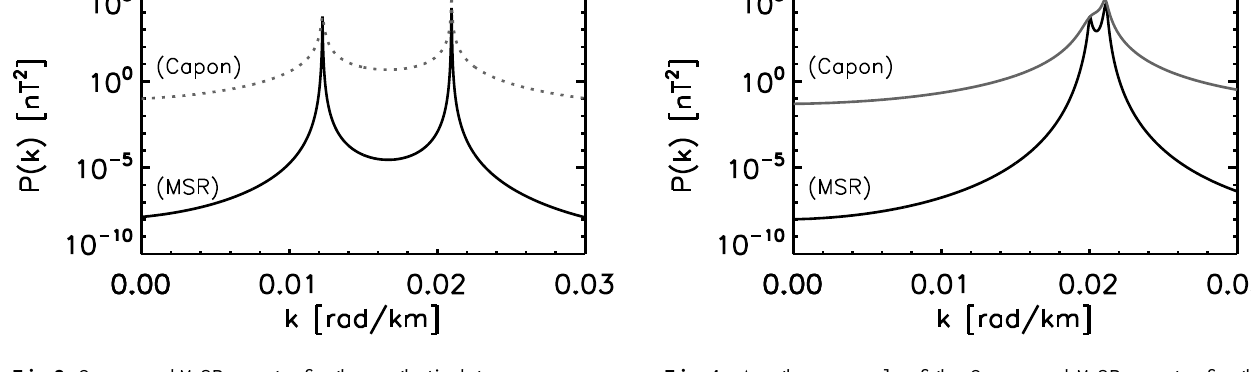
Fig. 3. Capon and MSR spectra for the synthetic data. Fig. 4. Another example of the Capon and MSR spectra for the synthetic